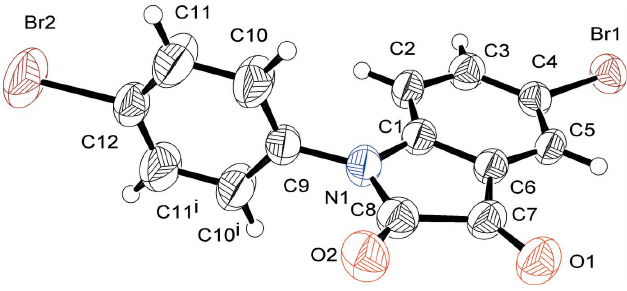
Figure 1 The molecular structure of the title compound showing 50% displace- ment systems is constrained to be 90 (cid:2) by symmetry. In the crystal, the molecules are linked by weak C—H (cid:3) (cid:3) (cid:3) Br interactions (Table 1) in the [001] direction and paired C—H (cid:3) (cid:3) (cid:3) O inter- actions to the same acceptor in the [100] direction, generating (010) sheets (Fig. 2). The layers are stacked along the b axis, resulting in possible extremely weak (cid:2) – (cid:2) overlap between neighbouring bromoisatino groups (Fig. 3). The centroid-to- centroid distance between adjacent isatin units is 4.431 (2) A˚ .